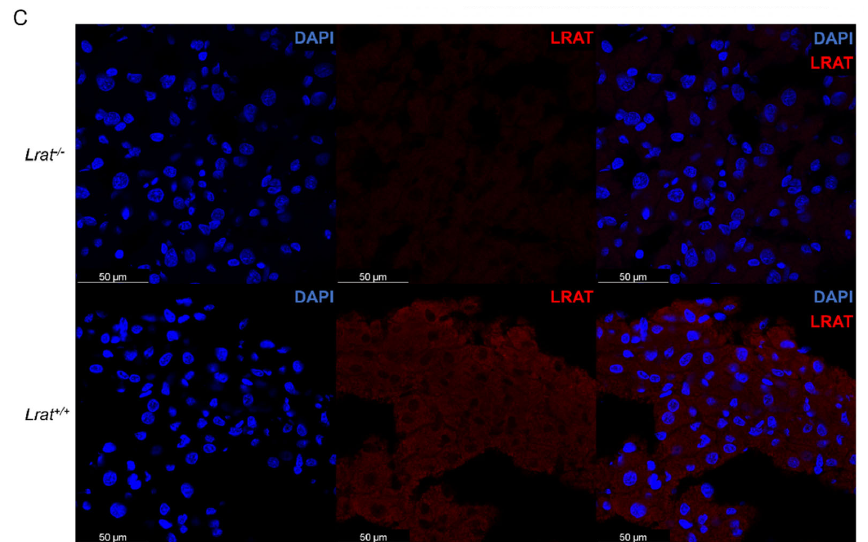
Figure 4. ( A ): mRNA expression of Lrat and Ef1a shown for Lrat +/+ and Lrat − / − animals for liver and eye tissues. Lrat expression was found in both wildtype liver and eye tissues. Significantly less RNA is found in Lrat − / − tissues. C1–3: Negative controls − / − cDNA in PCR reaction, − / − RNA in cDNA synthesis, and − / − SuperScriptIII in cDNA synthesis. ( B ): the presence of the introduced single nucleotide deletion and silent mutation in the Lrat mRNA of the Brown Norway rat was confirmed by Sanger sequencing. The rat reference sequence was retrieved from the NCBI database, Accession NM_02290.2. The open reading frame (ORF) of Lrat was determined using the ORFfinder (NCBI). ( C ): LRAT protein presence is confirmed in the liver of Lrat +/+ animals and (almost completely) absent in Lrat − / − liver tissue.